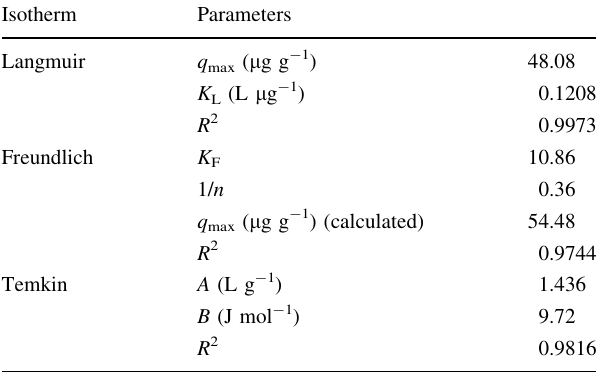
Table 9 Langmuir, Freundlich and Temkin isotherm model param- eters and correlation coefficient for adsorption of As(III) on MPKSF